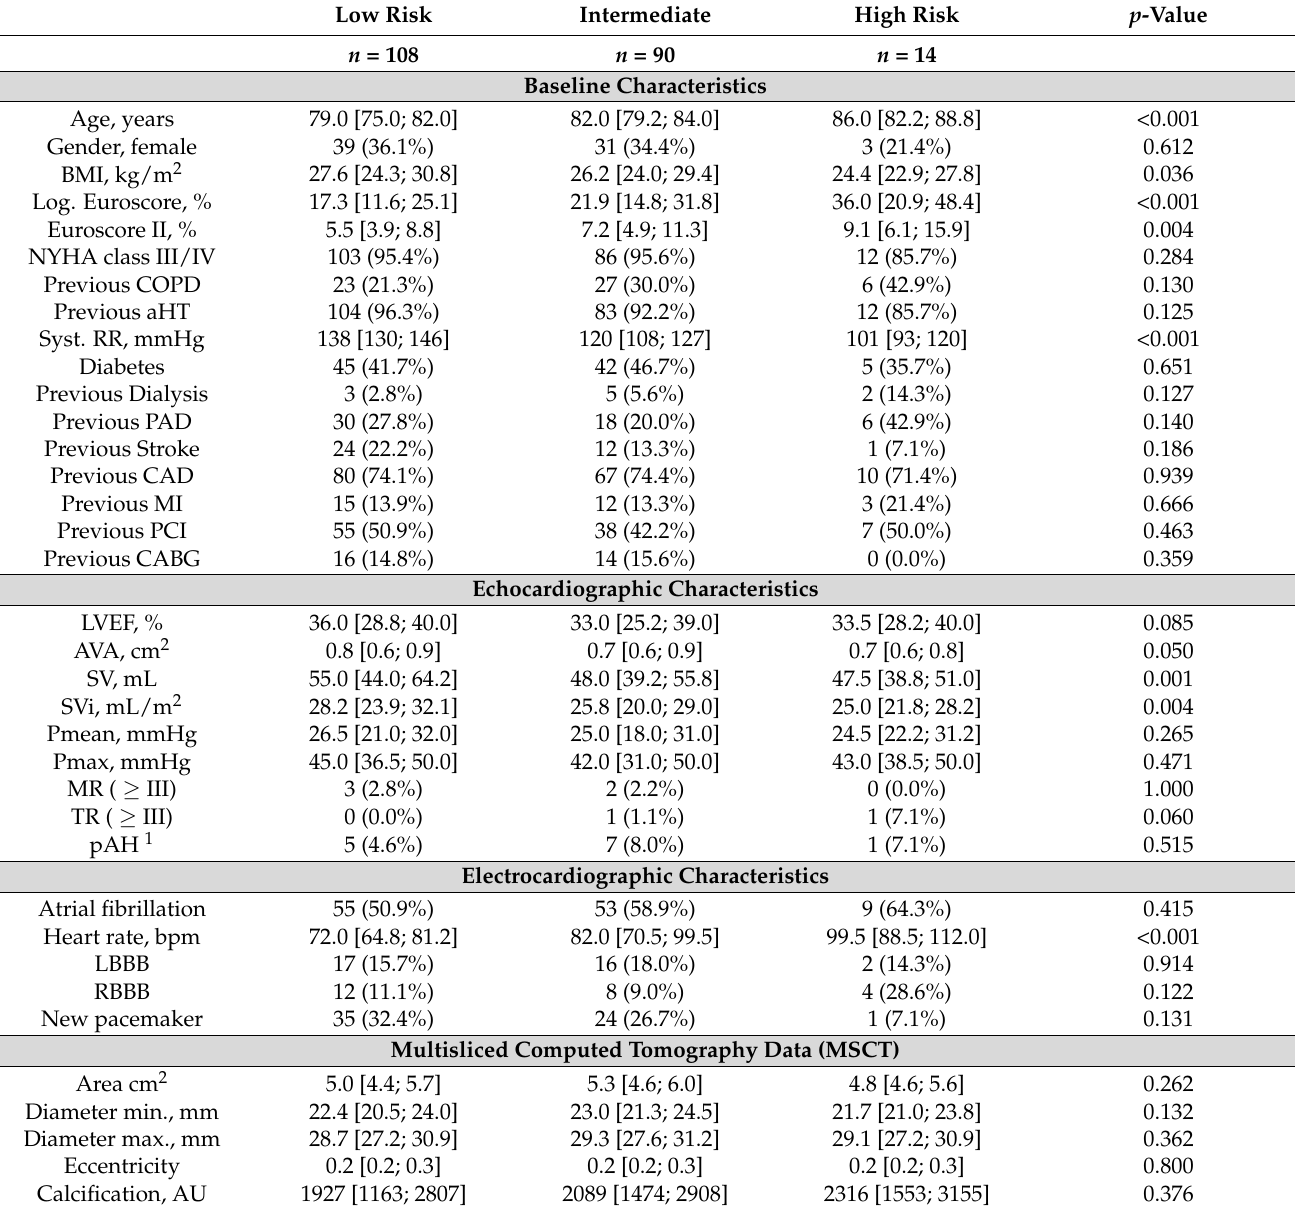
Table 1. Baseline